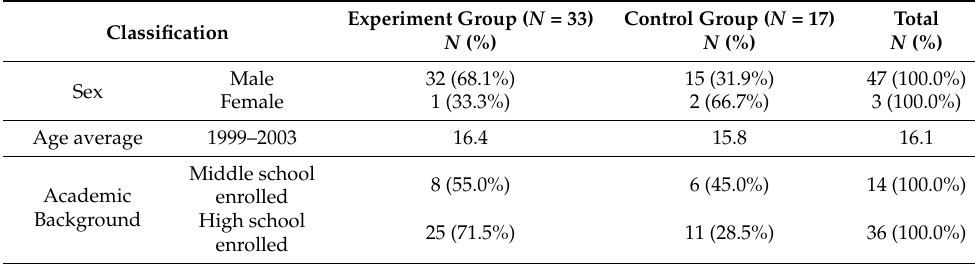
Table 1. Demographic characteristics of experimental and control